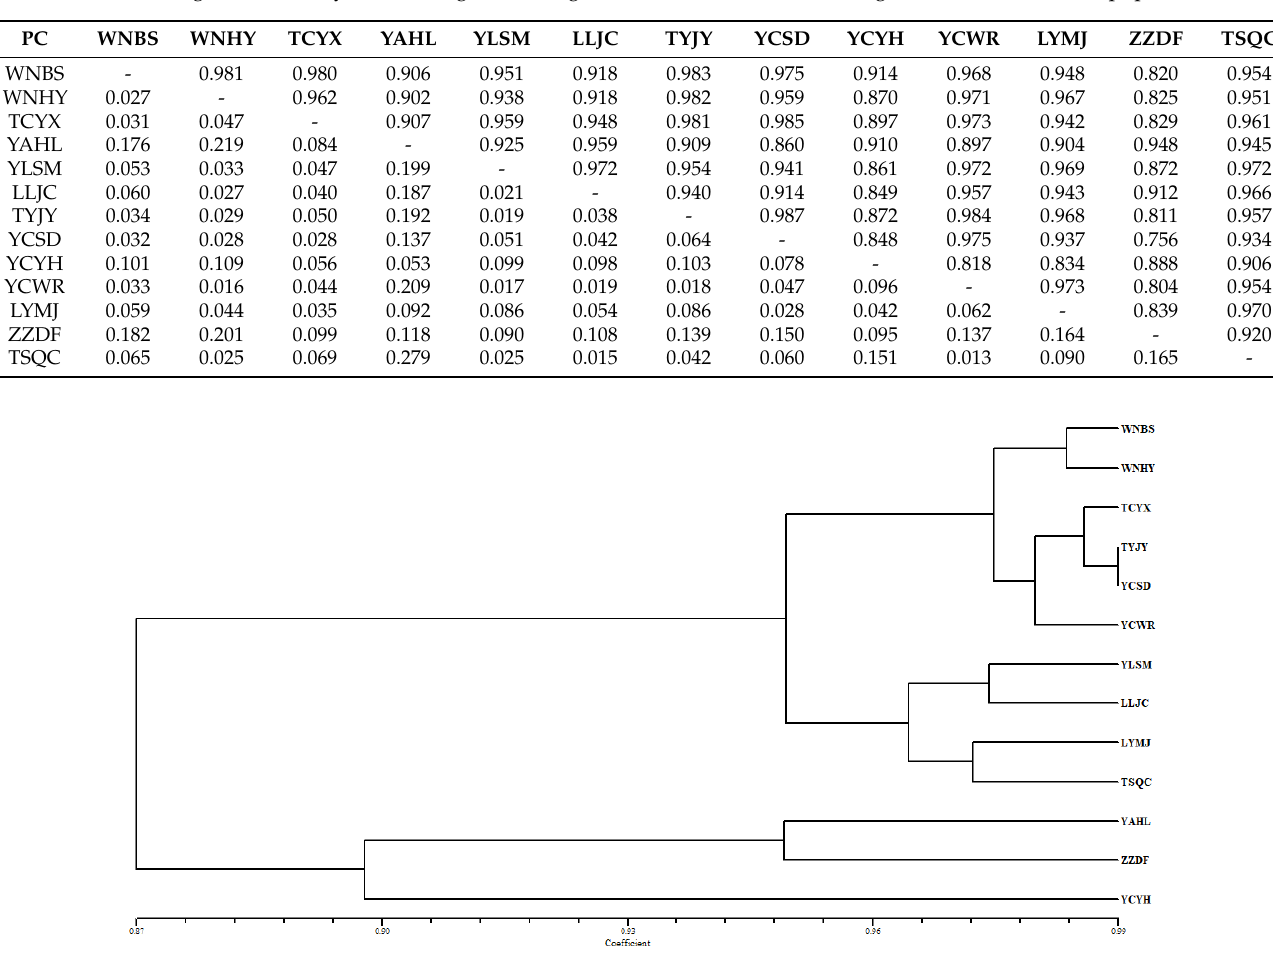
Figure 3. Genetic divergence among 13 populations of P. orientalis based on UPGMA clustering analysis.